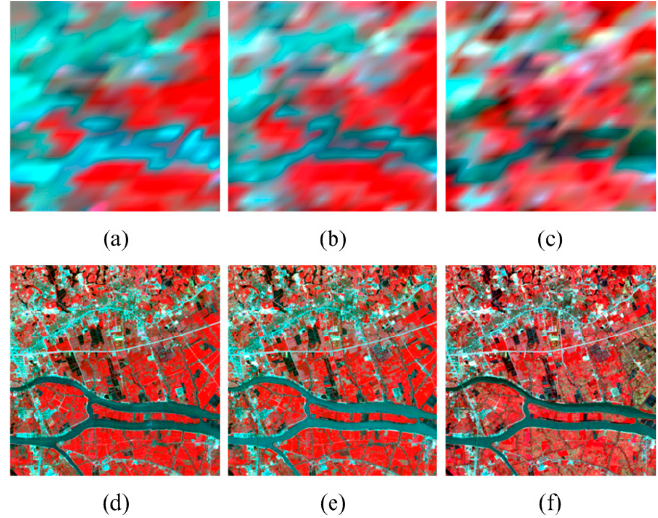
Figure 8. NIR–green–blue composites of MODIS imagery (upper row) and Landsat imagery (lower row) taken on ( a , d ) 29 August 2000, ( b , e ) 13 September 2000, and ( c , f ) 1 November 2000, respectively.